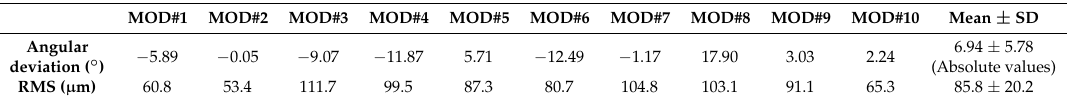
A plus sign in the angular deviation indicates that the post-operative provisional restoration is rotated in a clockwise direction, compared to the pre-operative STL data when viewed from the occlusal aspect; whereas, a minus sign in the angular deviation indicates that the post-operative provisional restoration is rotated in a counterclockwise direction. However, the mean and standard deviation of the angular deviations are calculated in terms of absolute values. MOD, model. SD, standard deviation. RMS, root mean square. STL, standard tessellation language.